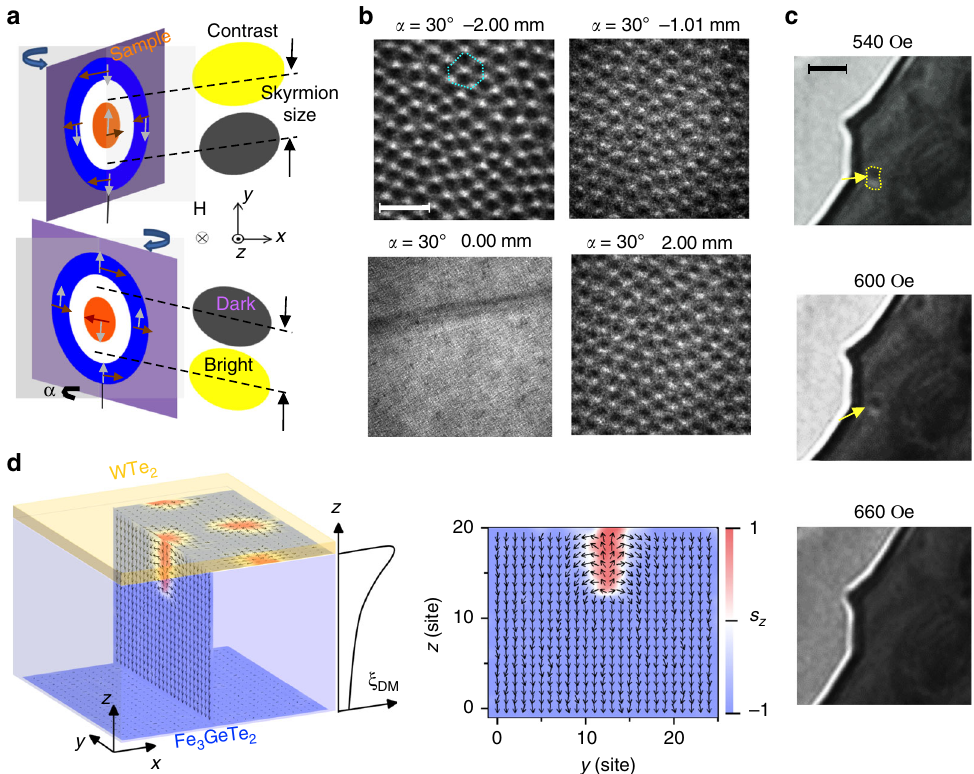
Fig. 3 Néel-type skyrmions observed by Lorentz transmission electron microscopy. a Schematic diagram of a Néel-type skyrmion on a tilt sample for Lorentz transmission electron microscopy imaging. The orange and blue circles are for positive and negative magnetizations along z direction, respectively. Brown arrows indicate the in-plane magnetization component while gray arrows indicate the Lorentz force. b Lorentz transmission electron microscopy observation of skyrmion lattice from under focus to over focus on WTe 2 /40L Fe 3 GeTe 2 samples at 180 K with a fi eld of 510 Oe. Scale bar: 500 nm. c Lorentz transmission electron microscopy observation of a Néel-type skyrmion at T = 94 K, α = 21.86° and H = 540, 600 Oe, where α is the angle between the sample plane and xy plane. The yellow arrow points to a skyrmion. The skyrmion size is ~150 nm. Scale bar: 500 nm. d Simulation